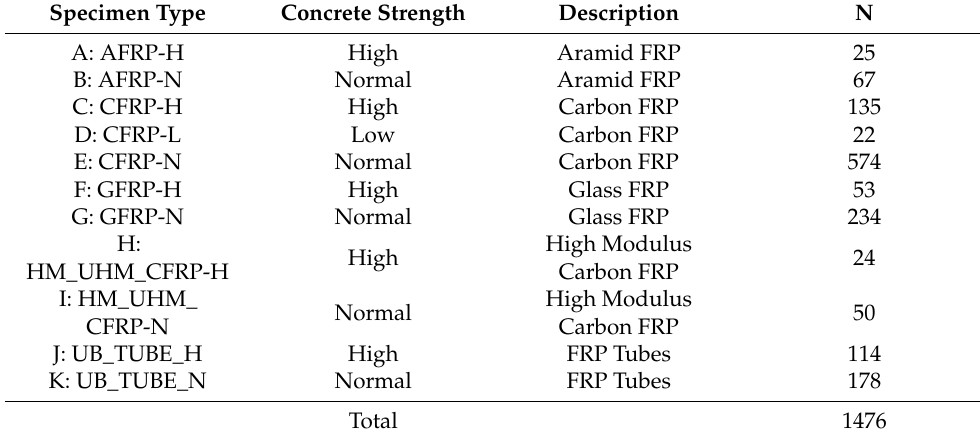
Table 1. Specimen